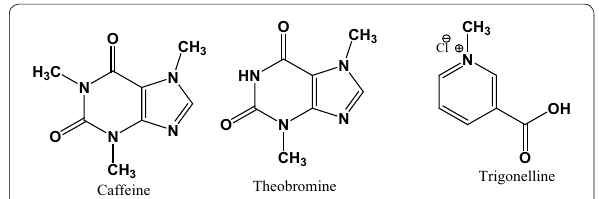
Fig. 1 Structures of the three coffee alkaloids